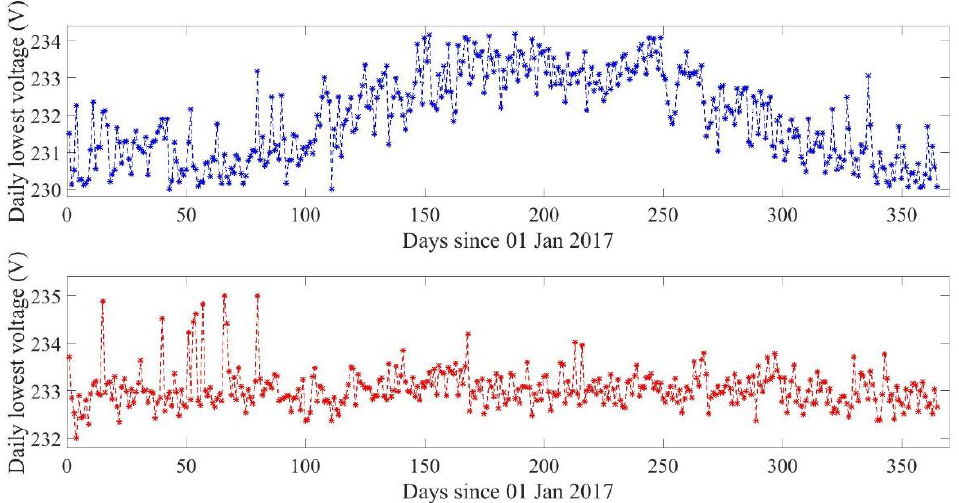
Figure 3. The measured background voltage for the 6-customers (100 kVA, top ) and 83-customers (500 kVA, bottom ) distribution network for 365 days of 2017.